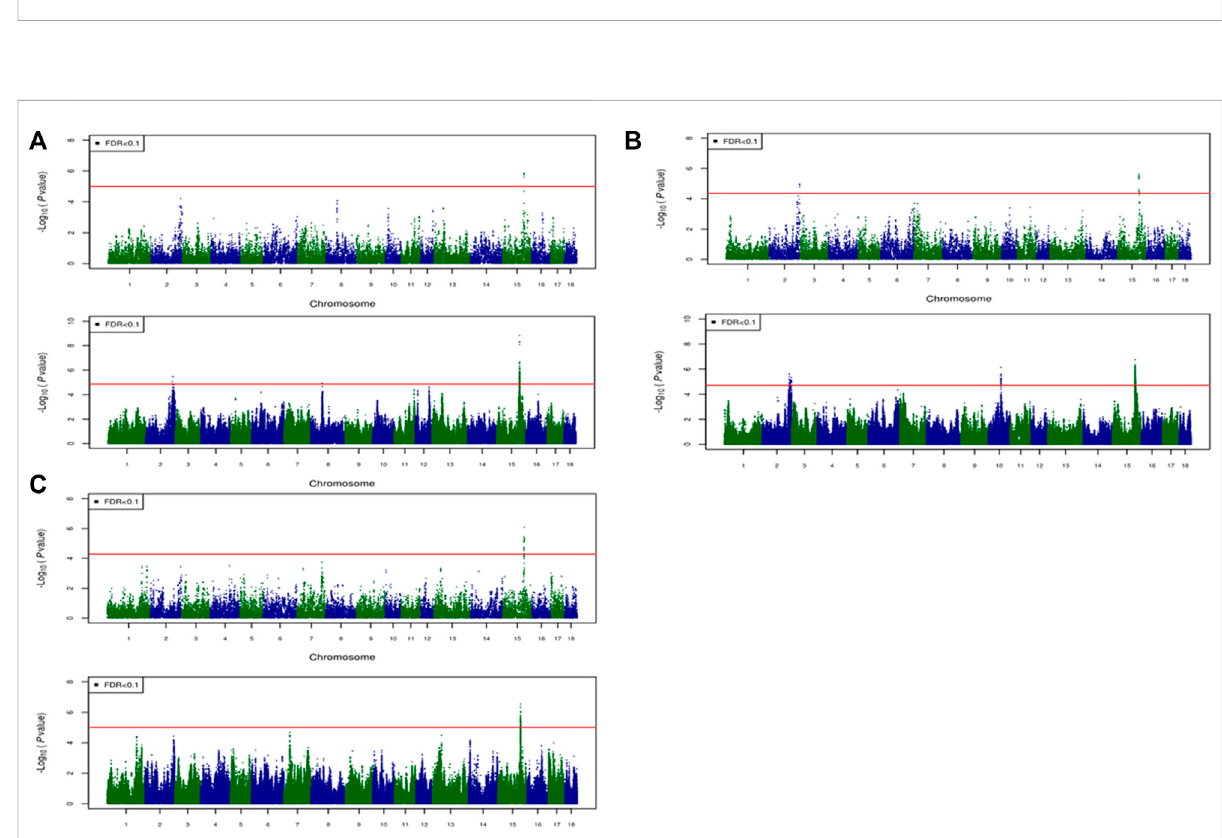
FIGURE 5 Associated regions detected by GWAS for purebred pigs. Manhattan plots for: (A) FMCOLB, (B) FMCOLL, and (C) ICOLB using a 50K medium- density panel (top Figure) and WGS (bottom Figure). The -log10 p -values of single-SNP association along the entire genome are plotted against the genomic position of SNPs along the 18 autosome chromosomes. The SNPs associated with the corresponding traits exceeded the signi fi cance threshold at false discovery rate (FDR) of 0.1, having signi fi cant